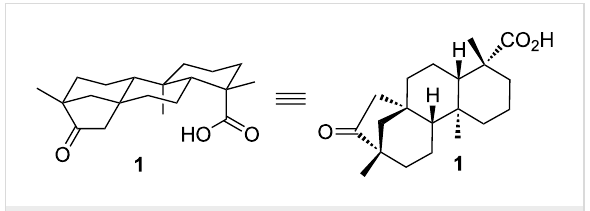
Figure 1: Unique structural features of ( − )-isosteviol.